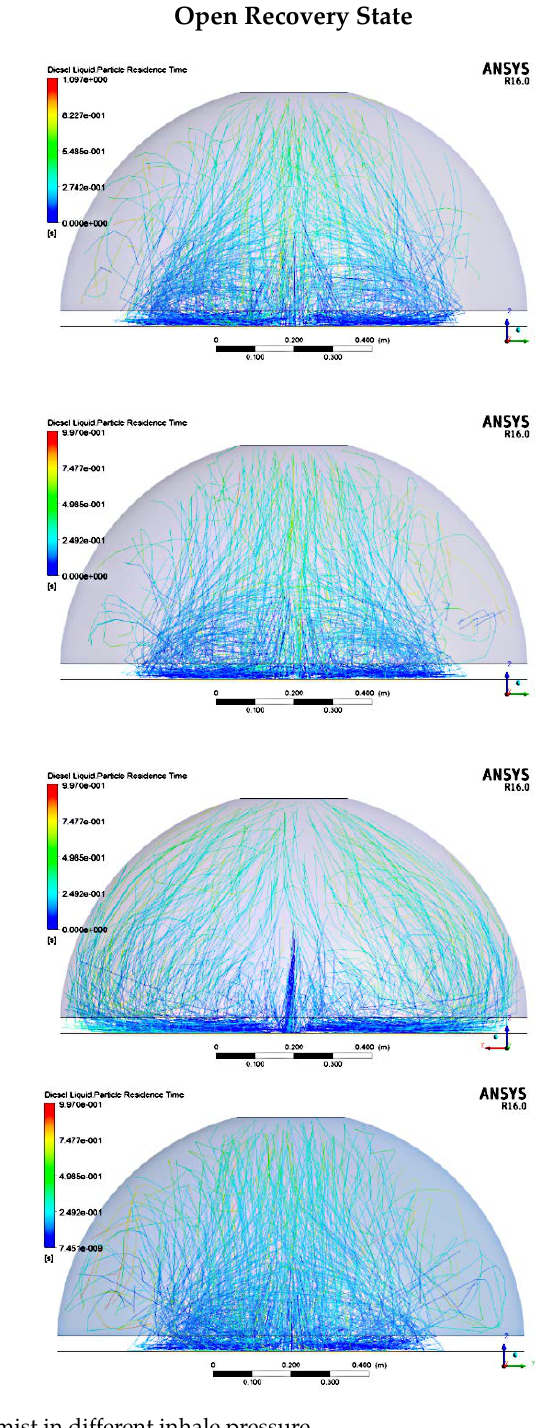
Figure 23. Motion trajectory of the paint mist in different inhale pressure.